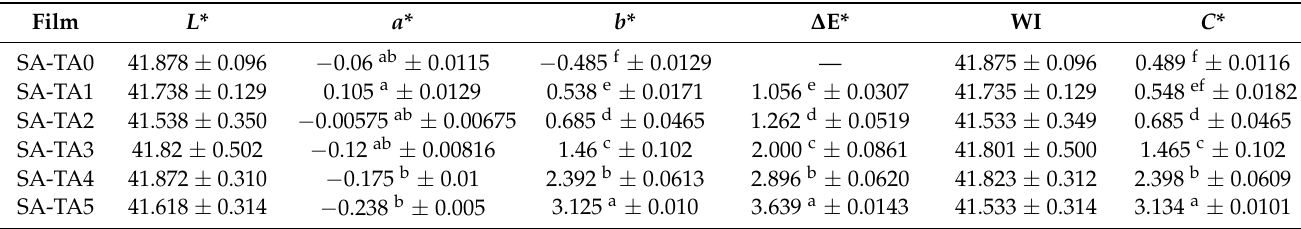
Table 2. Color parameters including L *, a *, b *, ∆ E*, WI, and C * of